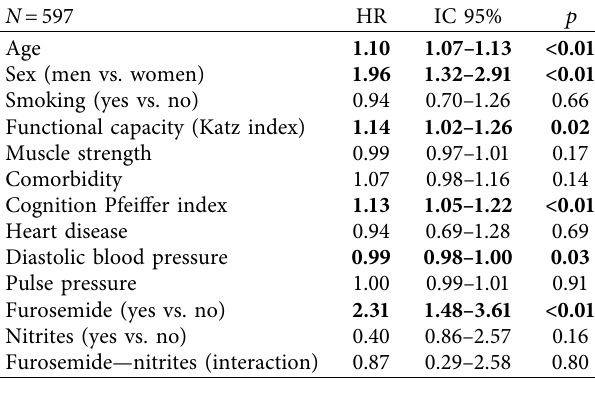
Table 4: Multivariate models of mortality at 5 years.